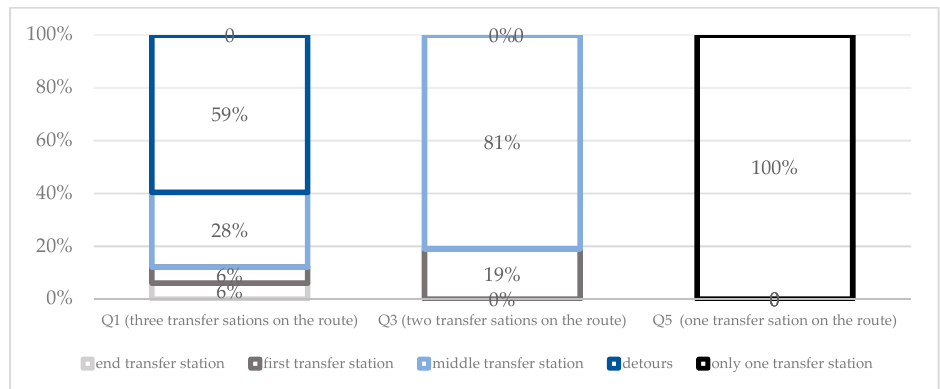
Figure 5. Locations of the selected transfer stations.